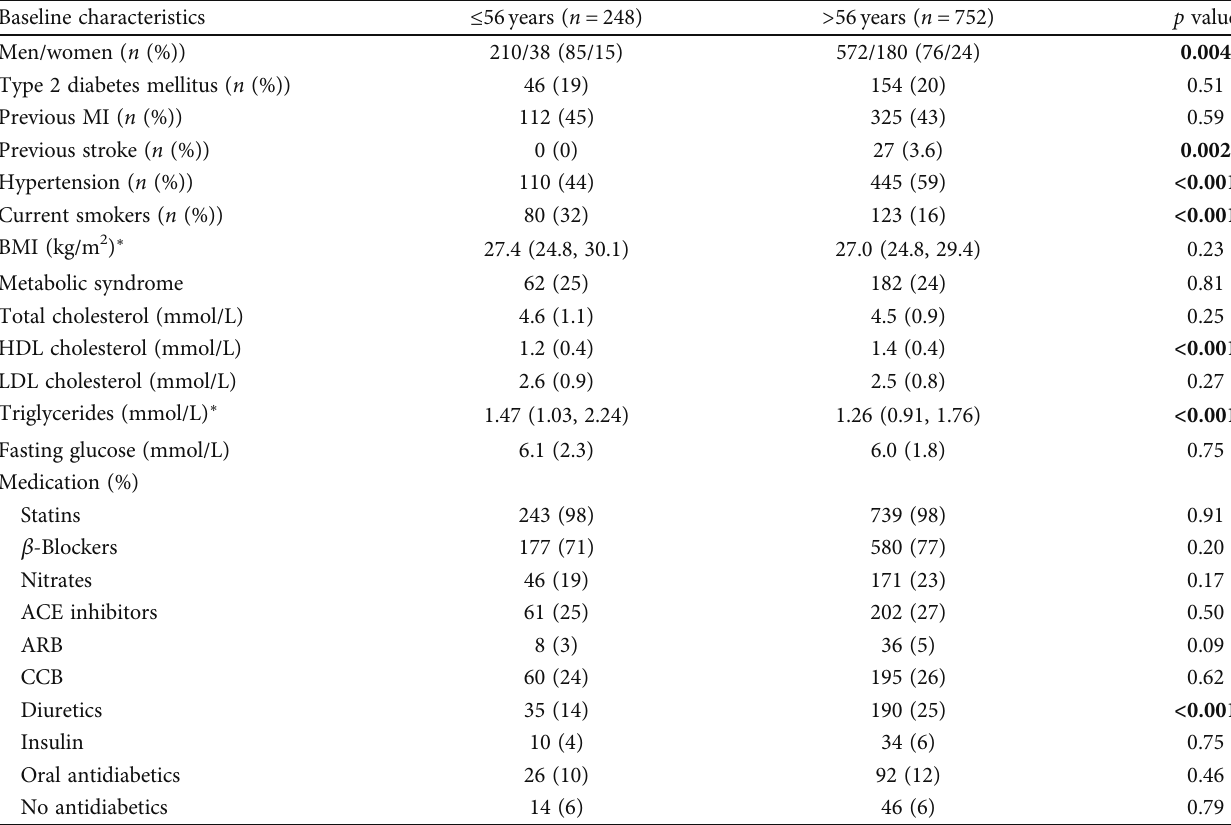
Table 4: Baseline characteristics of the total population according to age dichotomized at 56